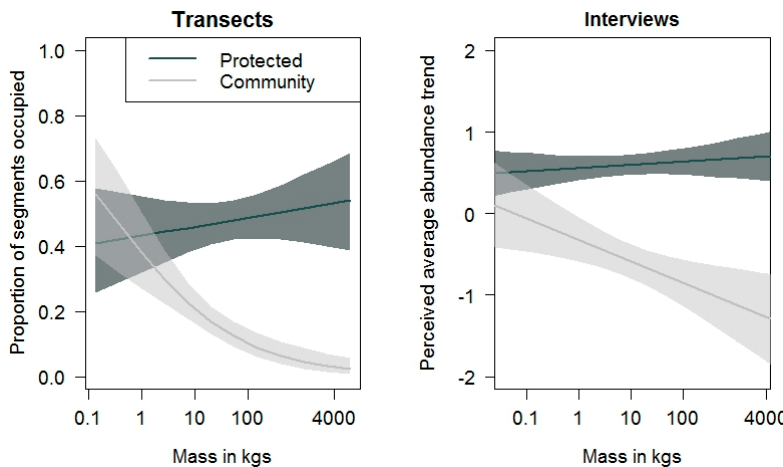
Figure 6. Graphical comparisons of transect and interview data from Pakke Tiger Reserve showing similar patterns of species abundance with body mass. Solid lines and their shaded polygons represent model fits and 95% CIs, respectively. The x-axis is on a log scale.